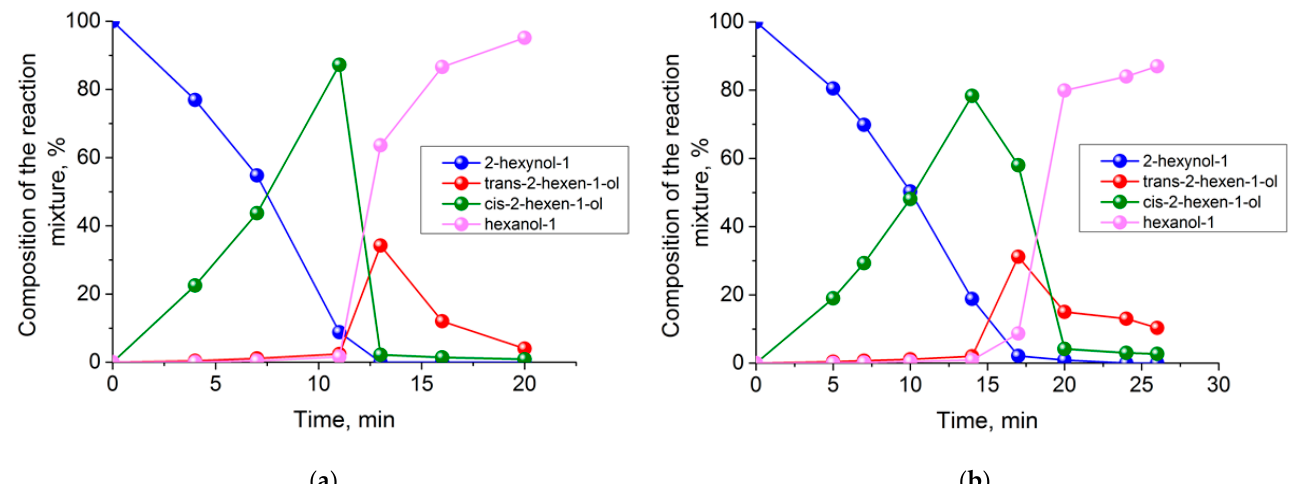
Figure 11. Changes in the composition of the reaction mixture during the hydrogenation of 2-hexyn-1-ol to cis-2-hexen-1-ol, trans-2-hexen-1-ol and hexan-1-ol in the presence of 0.5%Pd-PVP/ZnO ( a ) and 0.5%Pd/ZnO ( b ). Reaction conditions: T = 40 °C, P H2 = 1 atm, m cat = 0.05 g, solvent C 2 H 5 OH 0.25 mL, and C alkynol = 0.09 mol/L. The maximum yield of cis-hexen-2-ol on the polymer-free catalyst occurred at the fourteenth minute and was 78.3%, which corresponds to 96.4% selectivity for cis-2-hexen-1-ol at 81.2% conversion of 2-hexyn-1-ol. It should be noted that both catalysts show close stereoselectivity for cis-hexen-1-ol (Table 4).